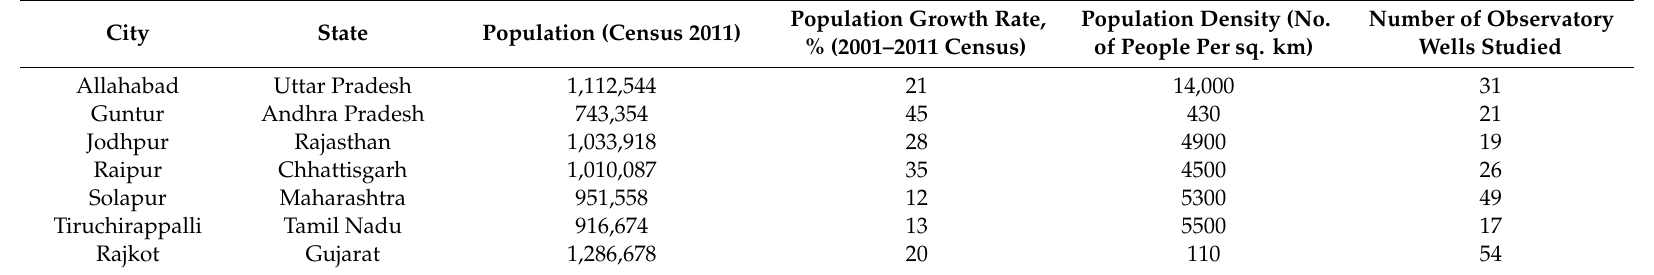
Table 1. Population and observation well